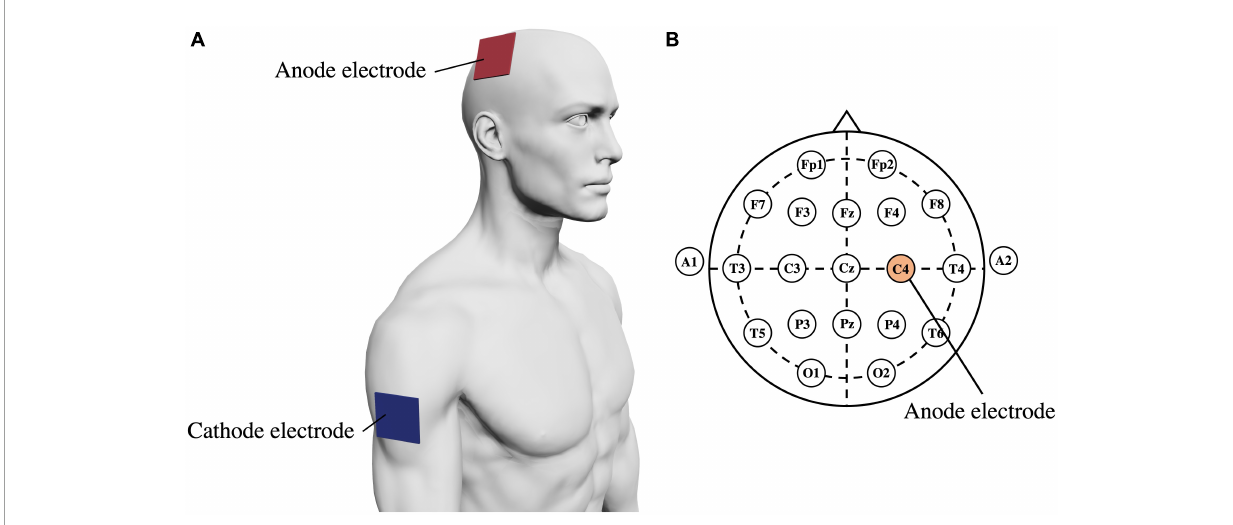
FIGURE3 (A) Electrode placement for tDCS. The anode electrode is placed over the right primary motor cortex, and the cathode electrode is placed on the right upper arm. (B) Electrode placement under the international 10–20 system. The anode electrode is placed on C4.